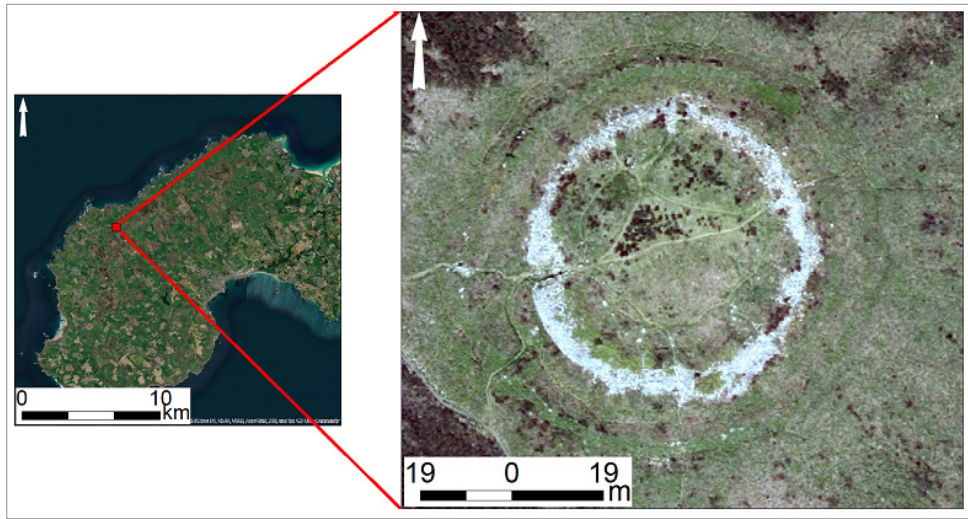
Figure 1. The study site depicted along with its location. Right: Satellite imagery of Cornwall in Scheme 2020. Google). Left: The study area—Chun Castle (Source: https://digimap.edina.ac.uk). Table 1. Archaeological features from previous studies revealed in the study site using excavation